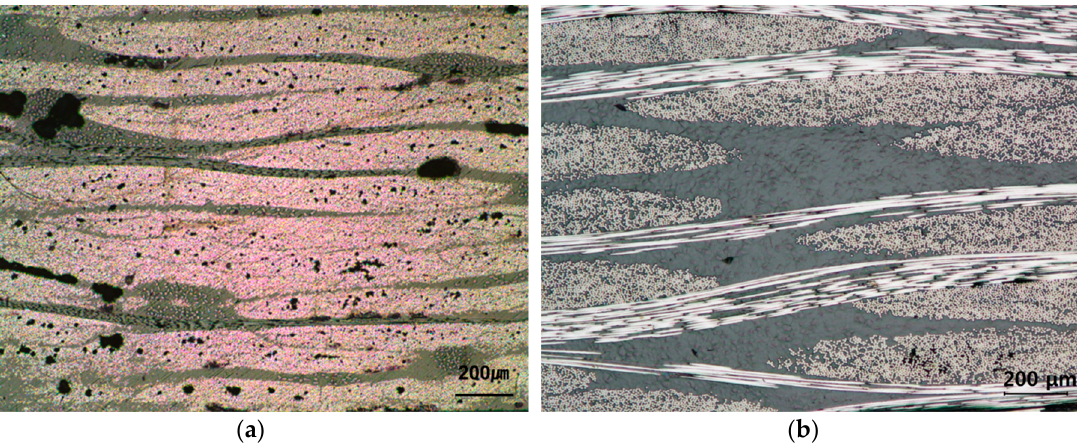
Figure 5. Cross-sectional microscope images of the carbon fiber reinforced composite specimens: ( a ) UD fabric; and ( b ) PW fabric.